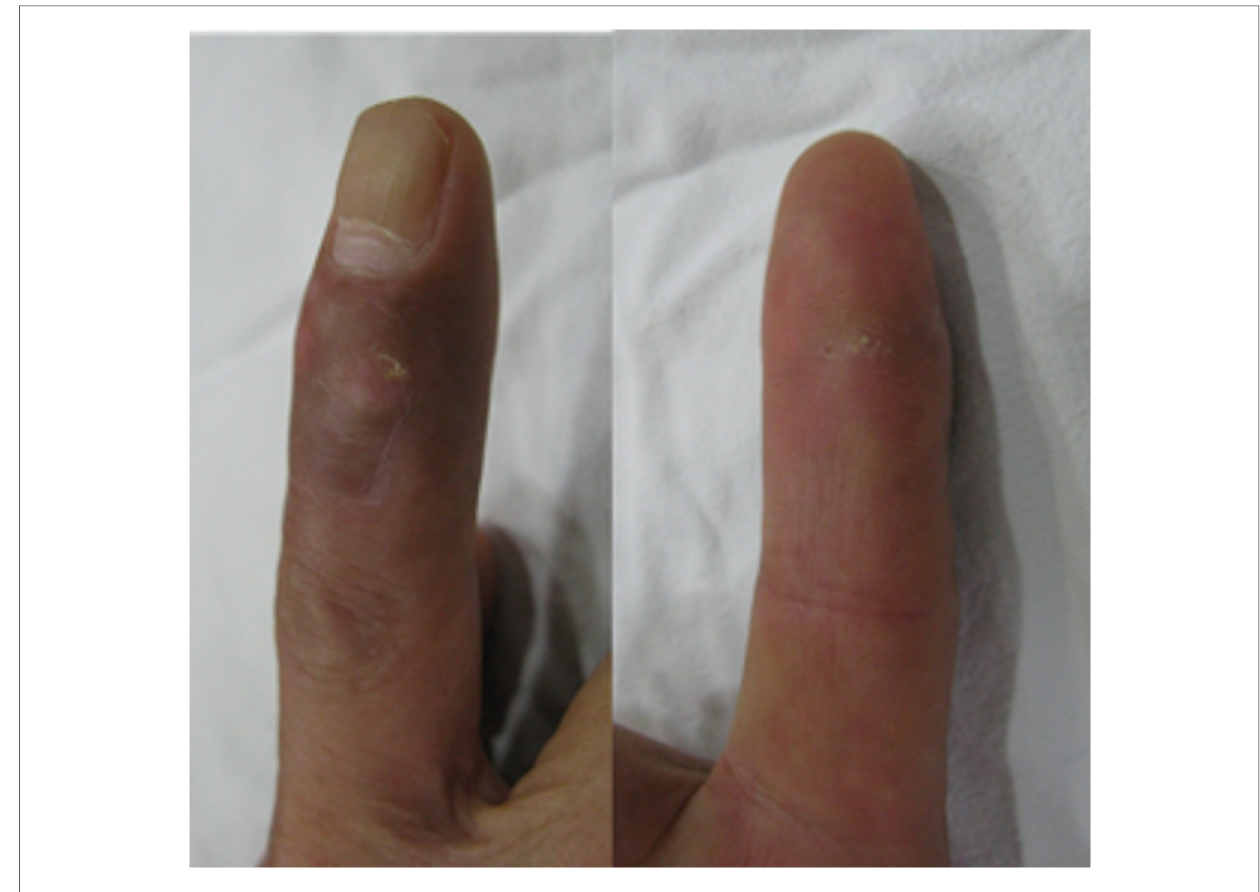
FIGURE 6 The fi nger after 1 month, by which time the pain and swelling had completely